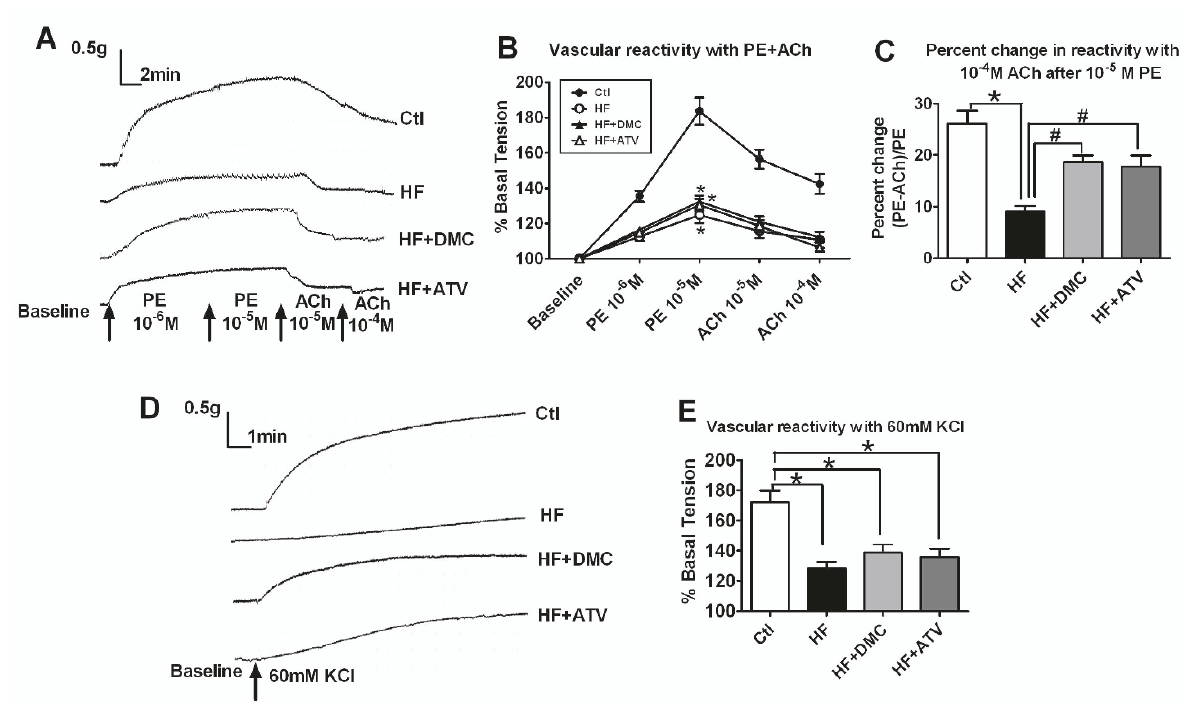
Figure 1 High-fat-induced loss of vascular reactivity of aortic rings and mitigation by DMC and ATV . ( A ) Typical tracing and ( B ) Representative line graph showing increased contraction and relaxation by increasing concentration of PE and ACh. ( C ) The percent change in relaxation ((tension PE - tension Ach)/tension PE) to 10 -4 M ACh after10 -5 M PE. ( D ) Typical tracing and ( E ) Vascular tension to 60 mM KCl in all groups. Data presented as mean ± S.E.M. and expressed as percentage of baseline tension. * P < 0.01 vs. control group, # P < 0.05 vs. HF, n = 16-18 rings from 6-7